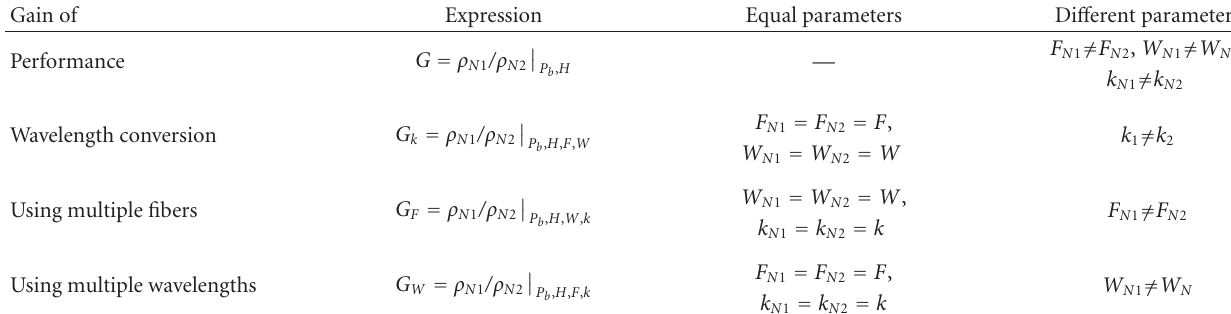
Table 2: Overview of the gain of